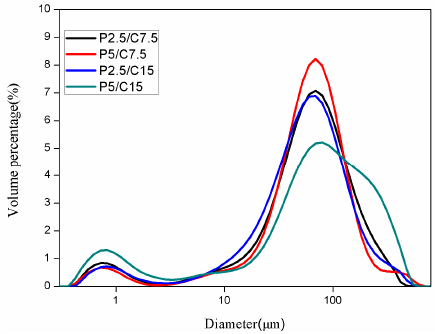
Figure 2. Size distribution of KSL-W-loaded PLGA and PLGA/CS composite microspheres. Table 1. The mean diameter and encapsulation efficiency of the PLGA/CS composite microspheres. MSs